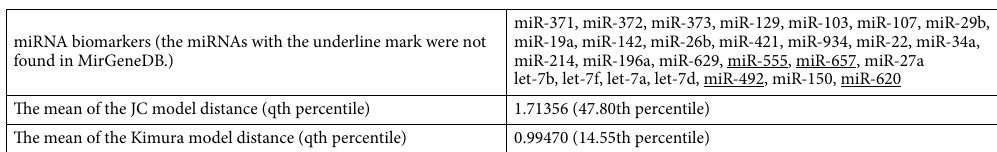
miRNA biomarkers (the miRNAs with the underline mark were not found in MirGeneDB.)